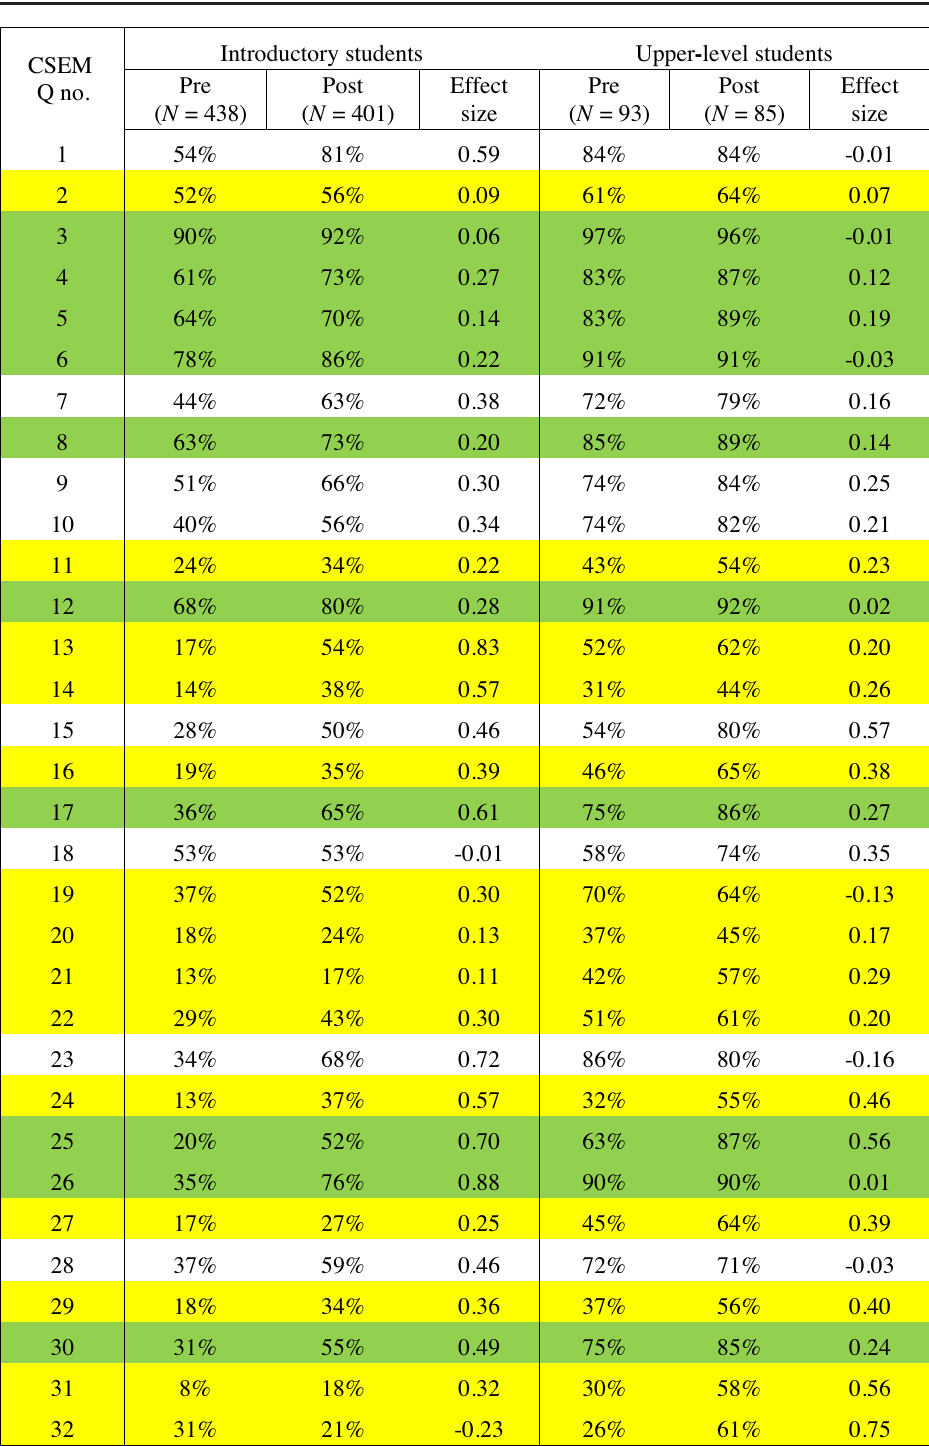
FIG. 1. Pre- and post-test performance of introductory and upper-level undergraduate students for each question on the CSEM along with effect sizes (Cohen ’ s d ) for the change from the pretest to the post-test. Questions on which the post-test performance of upper-level students is lower than 2 = 3 are highlighted in yellow (14 questions), and questions on which the post-test performance is above 85% (10 questions) are highlighted in